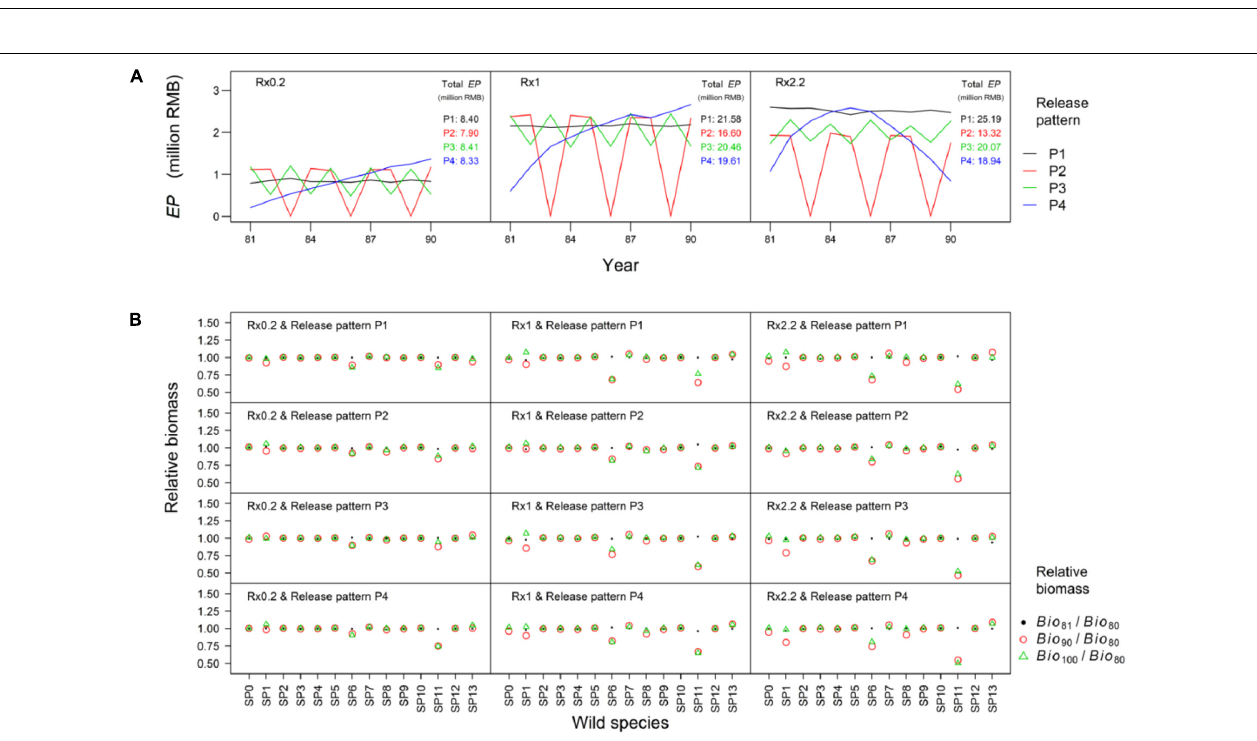
FIGURE 5 | The economic profit ( EP ) of F. chinensis release (A) and variations of wild species biomass (B) in S2. The F. chinensis release implemented from 81st year to 90th year. The total EP was the sum of EP (economic profit) in the release stage and presented in the figures. The calculation of indicators were shown in Table 2 . The Bio 80 , Bio 81 , Bio 90 , and Bio 100 were wild species biomass (i.e., SP0 to SP13) in the 80th, 81st, 90th, and 100th year, respectively.